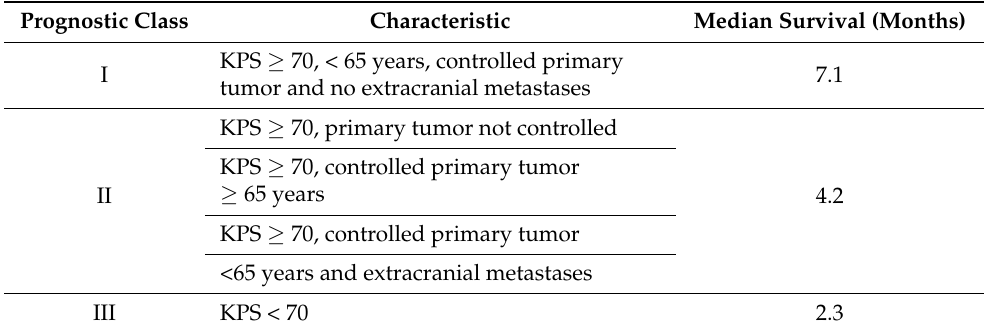
Table 1. Prognostic stages in patients with central nervous system metastases according to the Radiation Therapy Oncology Group (RPA). KPS: Karnofsky Performance